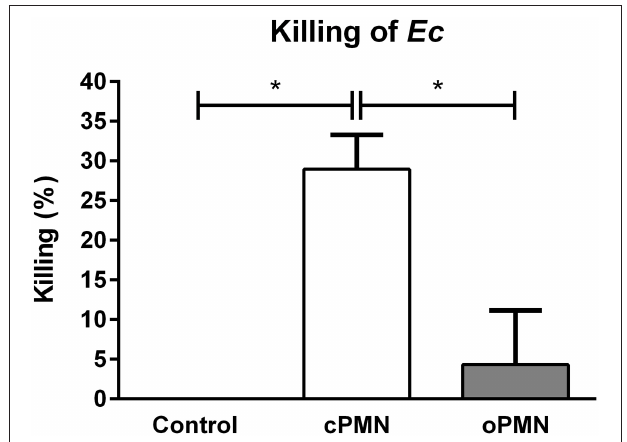
FIGURE 6 | oPMN have a limited ability for intracellular killing of Ec . Quantitative analysis of killing capacity (percentages) of cPMNs (white bar) and oPMNs (gray bar). Percentages are based on the presence of CFU on overnight Ec agar plate assays. The control condition, representing 0% killing, was Ec incubated alone. On average, cPMNs killed 29 ± 4% while oPMNs killed 4 ± 7%. cPMNs killed significantly more Ec than both the control condition ( p = 0.02) and oPMNs ( p = 0.02). Data are presented as mean percentages ( + SEM), n = 4, * p < 0.05.